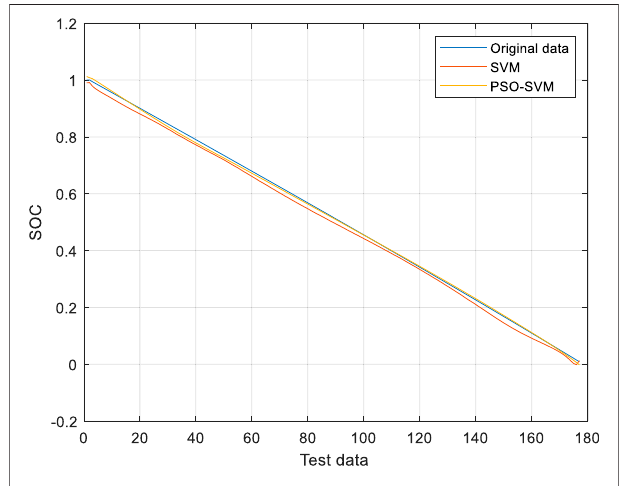
FIGURE 11 | SOC prediction of battery #2.